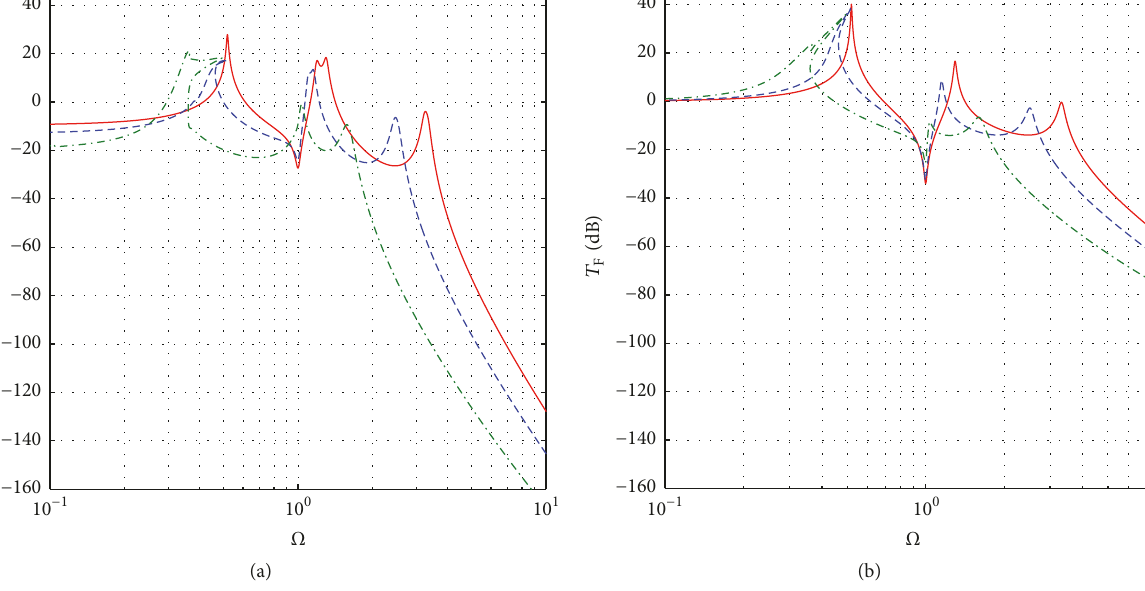
Figure 4: Power transmissibility (a) and force transmissibility (b) of the two-stage HSLDS system with different horizontal stiffness ( The parameters are 𝜇 1 = 0.2 , 𝜇 2 = 1 , 𝜆 1 = √5 , 𝜆 2 = 1 , system; blue dashed line,